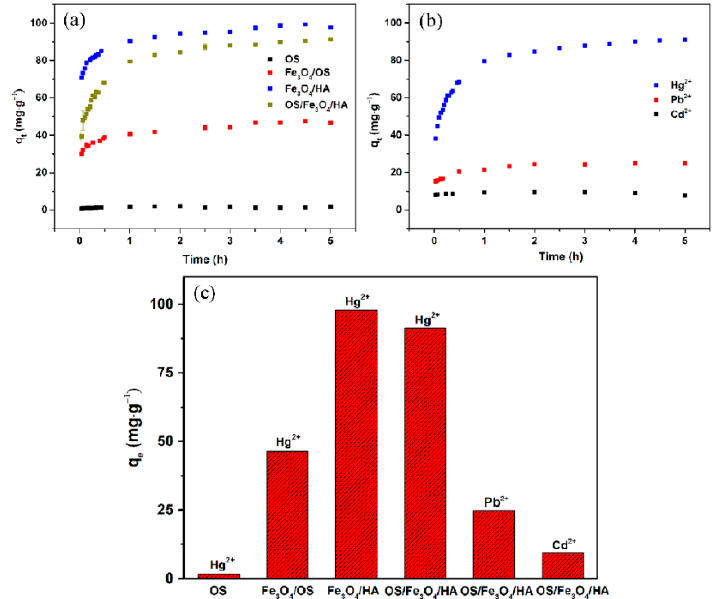
/ Fe / OS in various heavy metal 3 O 4